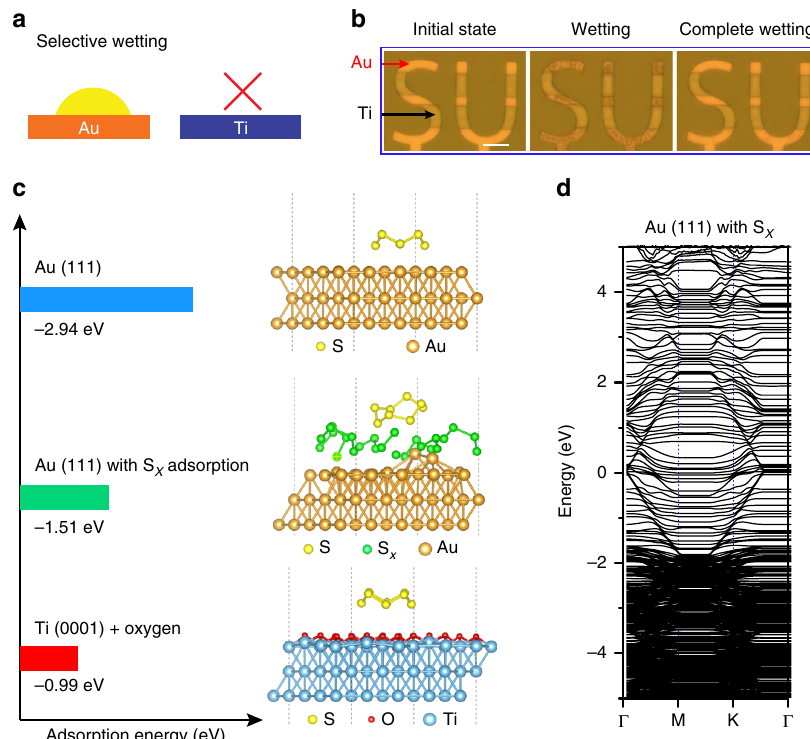
Fig. 3 Selective wetting and mechanism understanding. a Schematic and b patterned “ SU ” design illustrating substrate-dependent electrowetting of sulfur on gold and titanium. Scale bar in ( b ) is 10 μ m. c Adsorption energy and con fi guration of S 8 adsorbed on the surface of gold (111), gold (111) covered with S x layer and titanium (0001) covered by one layer of oxygen. d Band gap of gold (111) covered with S x